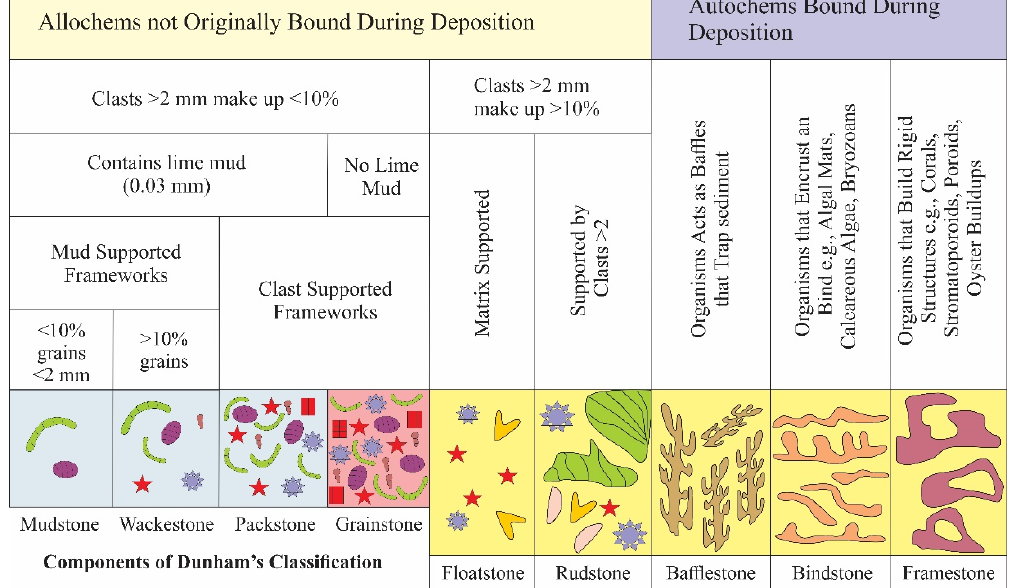
Figure 4. Representing the extended classification of limestone based on depositional texture.